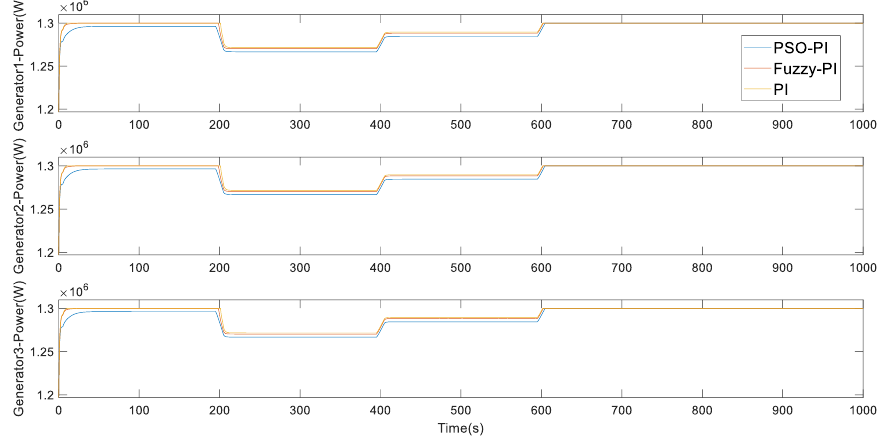
Figure 16. Output power of diesel generator in Example 1.